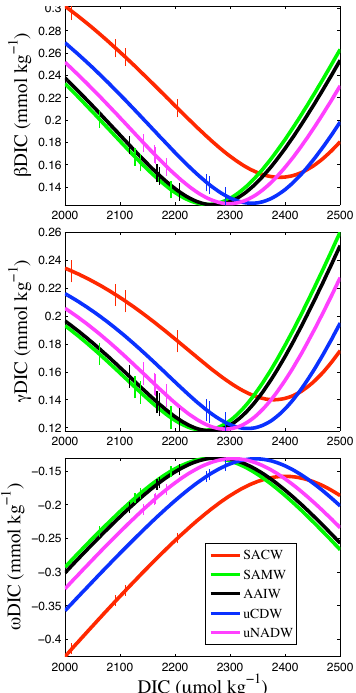
Figure 6. The buffer factors β DIC (top), γ DIC (middle) and ω DIC (bottom) of each water mass over a range of DIC concentrations. The vertical lines denote the DIC concentration in pre-industrial times, 1994 and 2011 and the projected concentration in